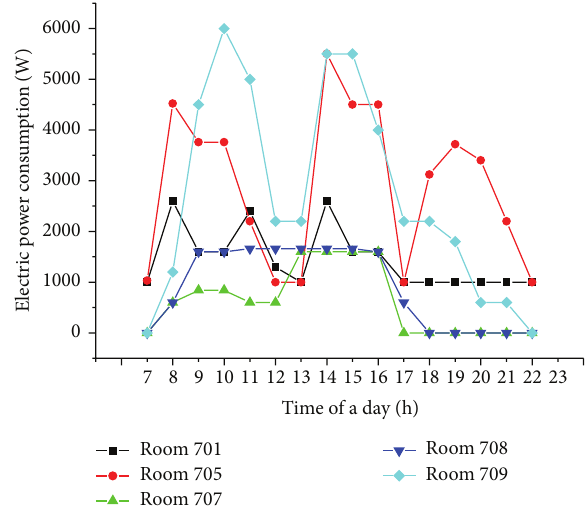
Figure 15: Electric power consumption of the testing